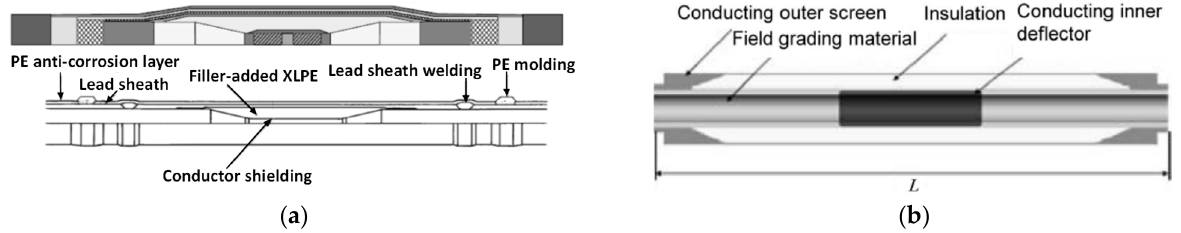
Figure 2. ( a ) Factory joint for HVDC XLPE submarine cable (±250 kV, 800 mm 2 conductor cross section, courtesy VISCAS;